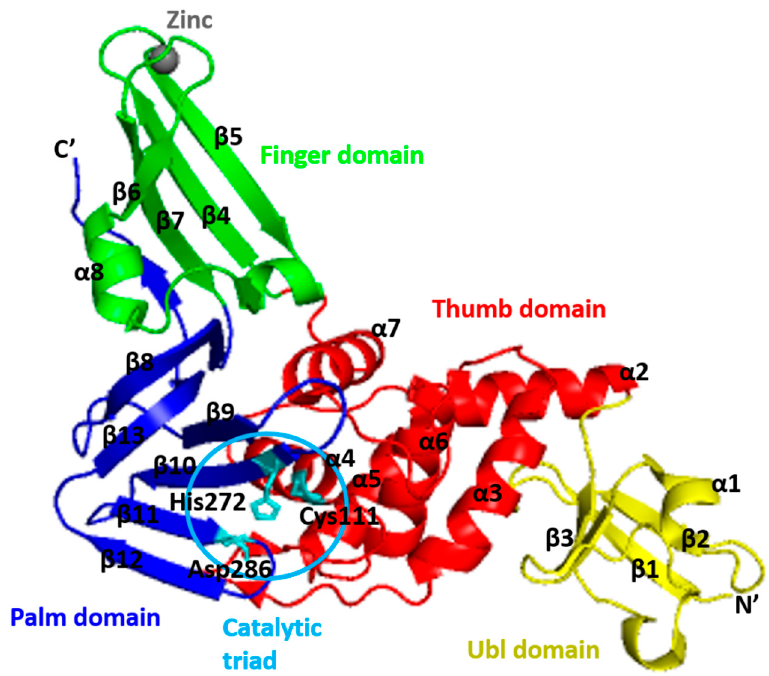
Figure 8. Cartoon representation of the SARS-CoV-2 PLpro. The thumb (residues 61–180) is coloured in red, the palm (residues 239–315) is coloured in blue, the finger (residues 181–238) is coloured in green, and the ubiquitin-like (Ubl) domain (residues 1–60) is coloured in yellow. The interface between the thumb and the palm forms the substrate-binding site leading to the catalytic triad of the active site comprised of Cys111, His272, and Asp286 (shown in stick).